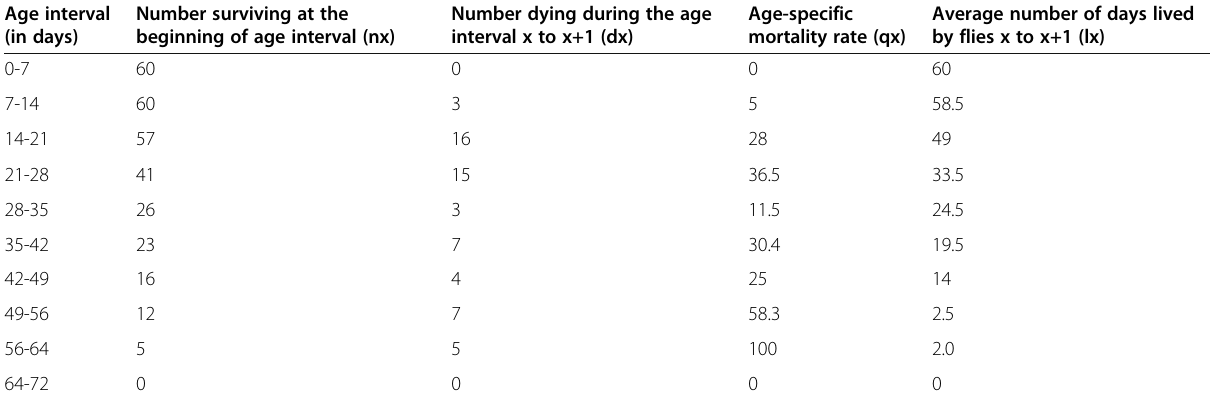
Table 1 Life table depicting survival of D. melanogaster in control medium Age interval (in days)